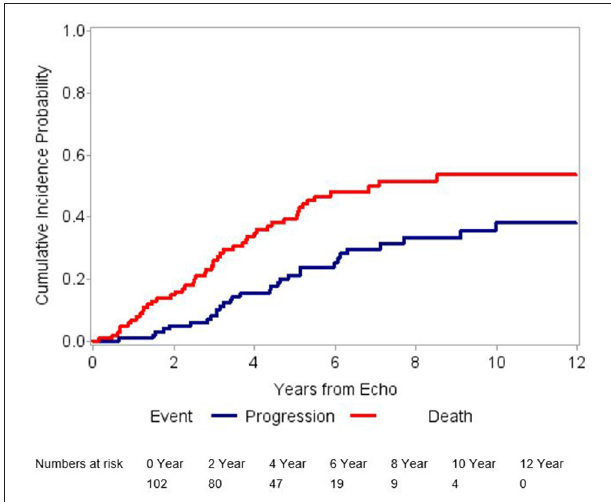
FIGURE 2 | Graphical representation of cumulative incidence probabilities. The blue line shows the cumulative incidence of aortic stenosis progression after adjusting for competing risk. The red line shows the cumulative incidence of the competing risk event (death without aortic stenosis progression). This figure suggests a high incidence of a competing risk